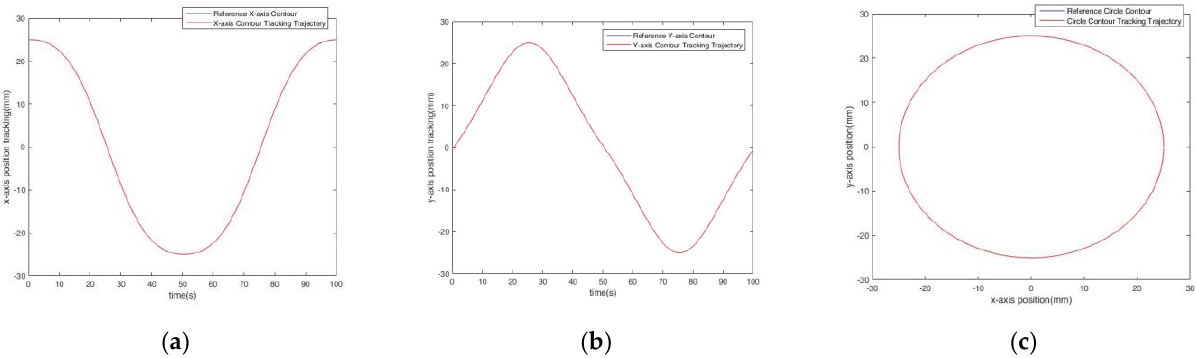
Figure 7. The path trajectory of the simulations. ( a ) The X − axis tracking response, ( b ) the Y − axis tracking response, ( c ) the circle path response.